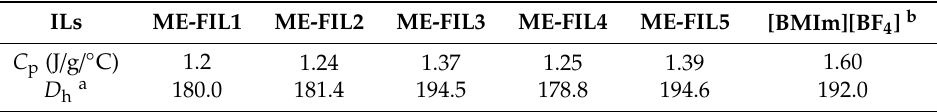
Table 3. Heat capacity ( C p ) and heat storage density ( D h ) for some